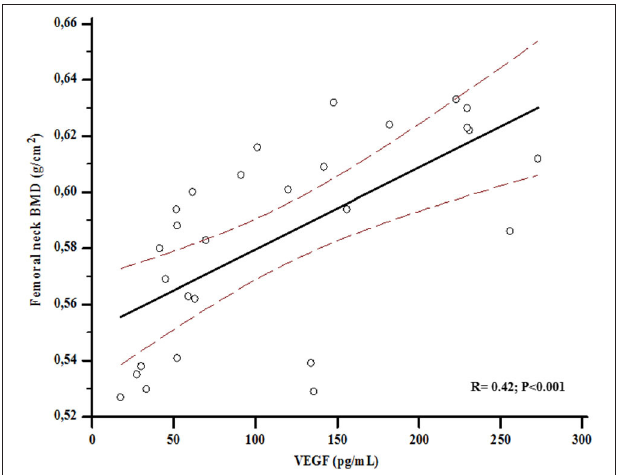
FIGURE 1 | Association between bone mineral density (BMD) at femoral neck and Vascular Endothelial Growth Factor (VEGF) levels at baseline.